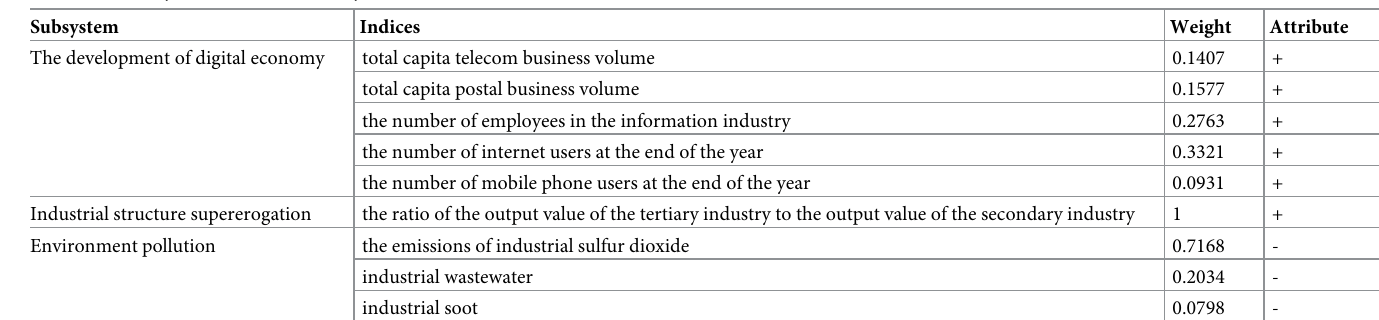
Table 1. Index system of the three subsystems.